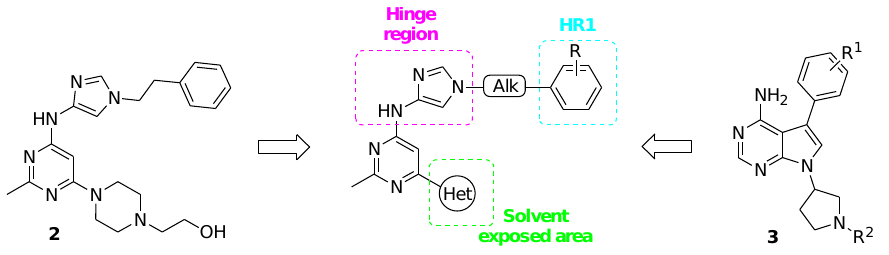
Figure 3. The mix and match strategy applied for the design of NCEs.